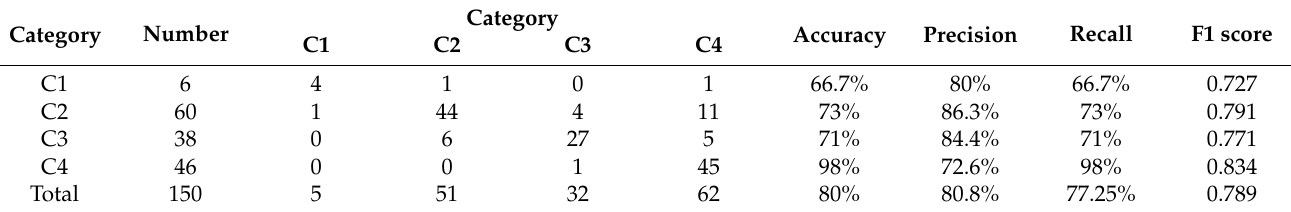
Table 6. Experimental results of SD-DT using size features for DT classification.